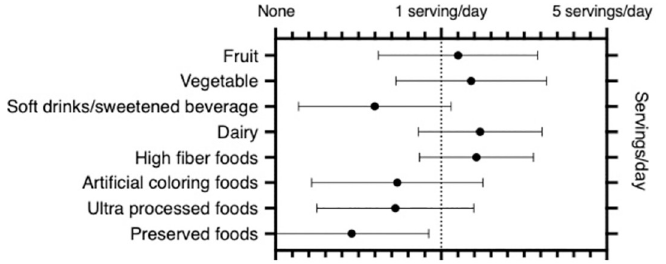
Fig 2. Pre-diagnosis dietary pattern. Pre-diagnosis dietary pattern shows a Westernized pattern of intake with lower amount of fiber, vegetables, and